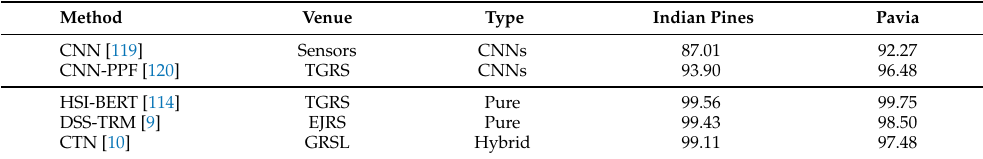
Figure 11. A qualitative comparison, in terms of visualization of classification maps between HSI- BERT and several CNN-based methods on the Pavia dataset. Here, ( a ) CNN, ( b ) CNN-PPF, ( c ) CD- CNN, ( d ) DRCNN and ( e ) HSI-BERT. Figure is from [114]. Table 7. Comparison in terms of overall accuracy (OA) of some representative CNN-based meth- ods with pure transformers and hybrid CNN-transformer-based hyperspectral image classification methods on two popular benchmarks: Indian Pines and Pavia. Here, the results are reported using 200 samples for training for each